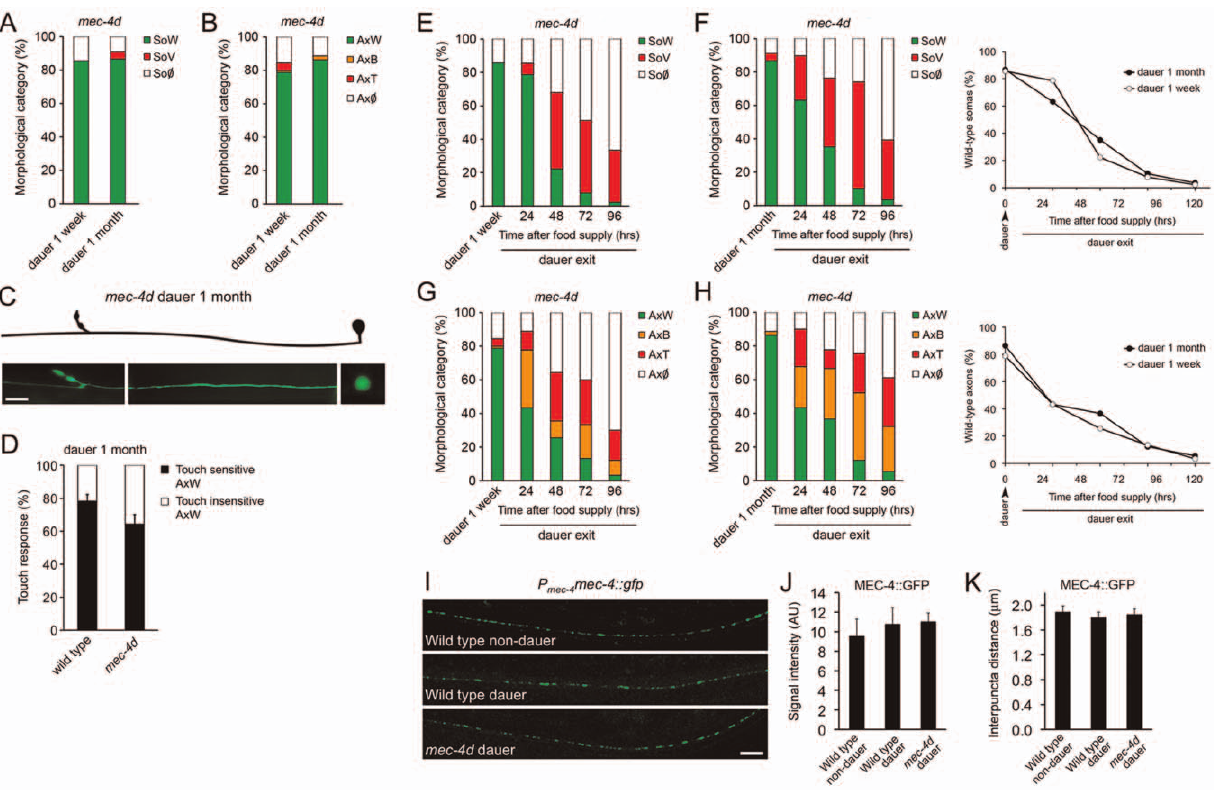
Figure 2. C.elegans dauer state prevents neuronal degeneration triggered by mec-4d . mec-4d dauer worms were scored by morphological and functional readouts. Both AVM somas (A) and axons (B) were protected from degeneration when worms were kept in a dauer state for one week or one month (mean value for each category is shown; error bars [ , 0.1%] are not included; N=3 of 30 worms each per group). (C) Morphologically conserved AVM neuron from a mec-4d mutant kept in diapause for 1 month. Scale bar, 10 m m. (D) Anterior touch response of mec-4d mutants kept in diapause for one month. Both wild-type (N2) and mec-4d groups have wild-type somas and axons as studied after the touch test by fluorescent microscopy. An equal fraction in both groups is unresponsive, which represents a dauer-dependent trait (mean values are shown, error bars indicates SEM, N=3 of 20 worms each per group). (E–H) Degeneration of somas and axons during dauer exit by food reposition takes place in a rate that is independent to the dauer length. Line graphs in F and H (right side), represent the rate of decay of wild type somas (F) and axons (H) during dauer exit (mean value for each category is shown; error bars [ , 0.1%] are not included; N=3 of 30 worms each per group; Student’s t test at each time point was performed for SoW and AxW categories, no significant differences were found between groups). (I) In uIs58 wild-type non-dauers and dauers expressing MEC-4::GFP (P mec-4 mec-4::gfp) , the GFP signal was expressed in a punctate pattern along axons, as in animals with the mec-4d ( e1611 ) mutation. Scale bar, 10 m m. Quantification of MEC-4::GFP signal intensity (J) and interpuncta distance (K) reveal no significant differences between conditions (N=9 worms per group; analyzed by Student’s t test compared to wild-type non-dauer values).